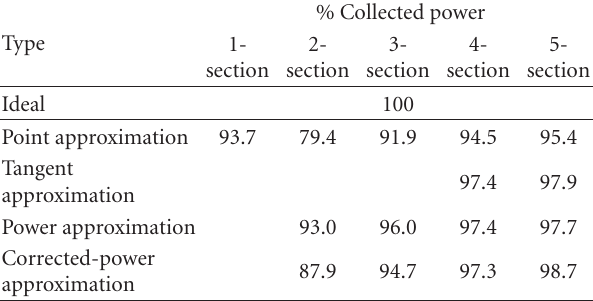
Table 1: Simulation results in terms of collected power at the out- put port. The flux collected by the ideal surface is also reported for